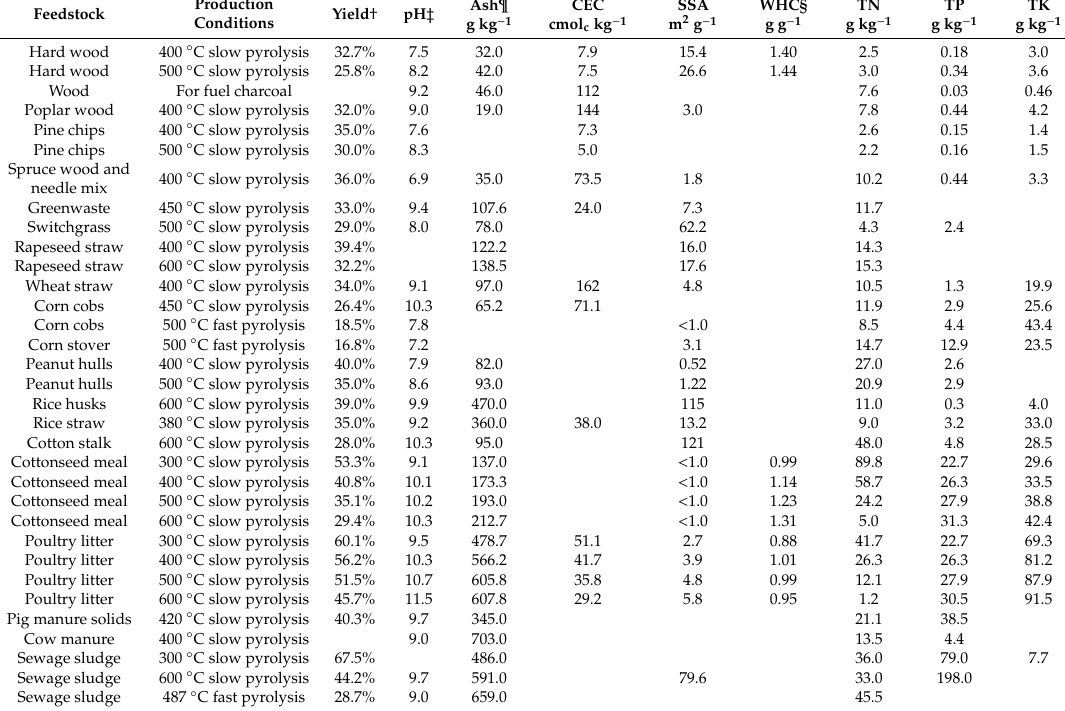
Table 1. Yield and quality variations of biochar as a function of the feedstock and production conditions [13,42,49–51].